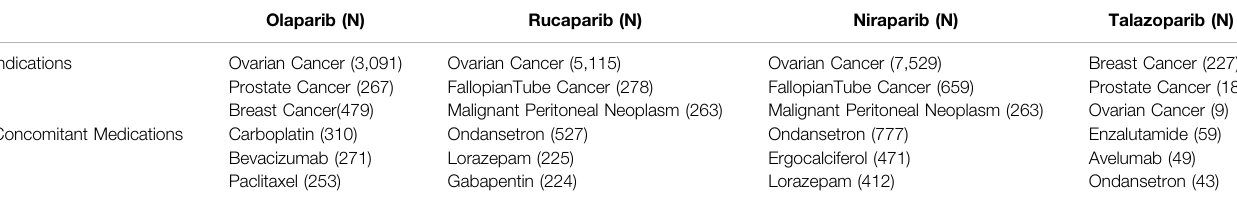
TABLE 3 | Top three indications and concomitant medications for PARPi AEs from the FAERS